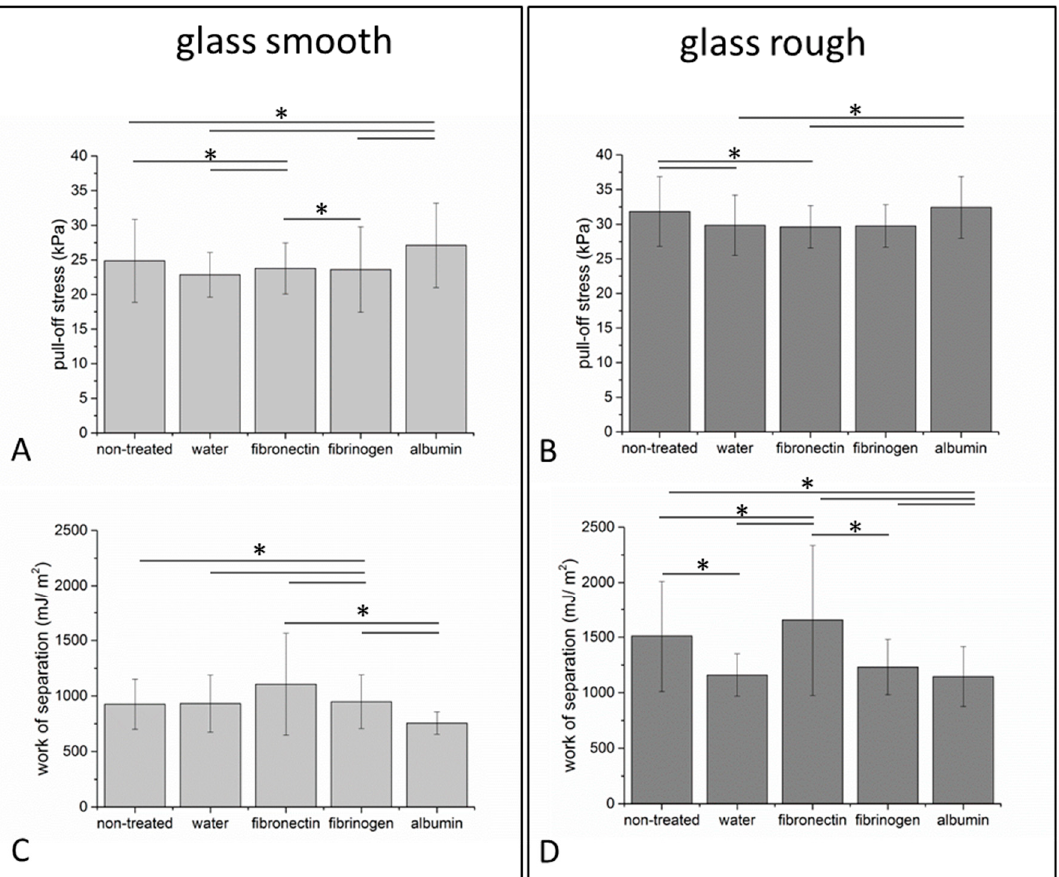
Figure 4. Determination of characteristic adhesion parameters by normal tack analysis. Pull-off stress ( A ) and ( B ) and work of separation ( C ) and ( D ) of SSA films were determined with two glass substrates with different surface roughness (glass smooth ( A ) and ( C ): R Z = 0.12 ± 0.004 µm; glass rough ( B ) and ( D ): R Z = 2.055 ± 0.017 µm) and constant retraction velocity of 10 µm/s. Films were functionalized with fibronectin, fibrinogen, and albumin and compared to control conditions (films immersed in water or non-treated). All films exhibited a thickness of 170 ± 30 µm. Comparable pull- off forces and work of separation were detectable within each group. Number of independent experiments: n=3. * indicates p ≤ 0.05. Original data is included in supplementary Table S1.